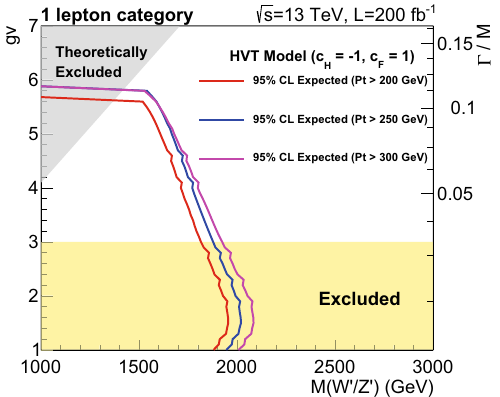
Fig. 12 Expected 95% CL HVT limits as a function of the reso- nance mass and width, for an integrated luminosity of 200 fb − 1 . The limits for the 2-lepton category are shown for increasing p ⊥ > 200 , 250 , 300 GeV selections. The theoretically excluded regions cor- respond to regions of small physical mass and large g V coupling, where the HVT model cannot reproduce the SM input parameters α EW , G F and M Z